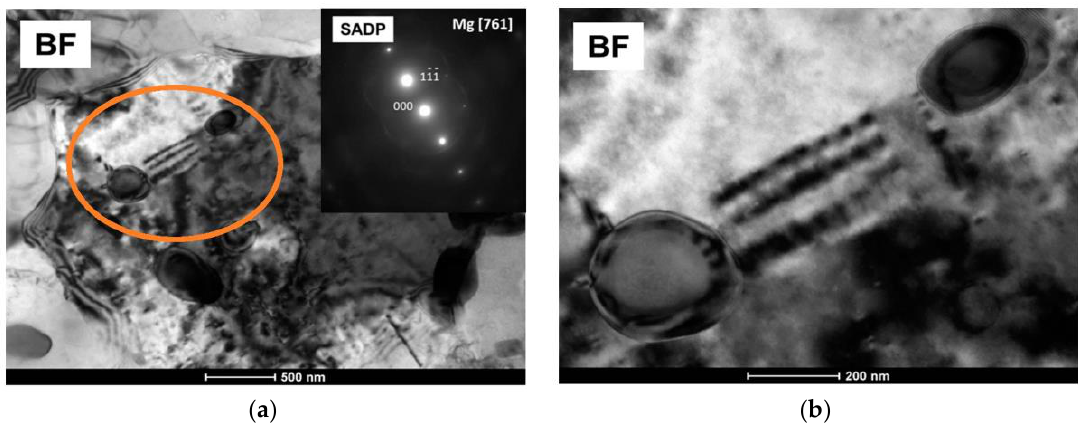
Figure 14. BF image at the two different magnifications ( a ) and ( b ) performed in two beam conditions for Mg [761] zone axis in the sample after three passes of TCAP.